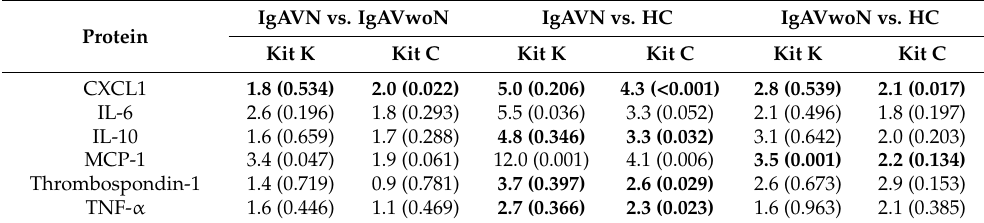
Table 3. Proteins reported significant by one comparison in at least one kit. Data are presented as the fold change ( p -value). The bold text highlights discrepancies in the results of significance between the